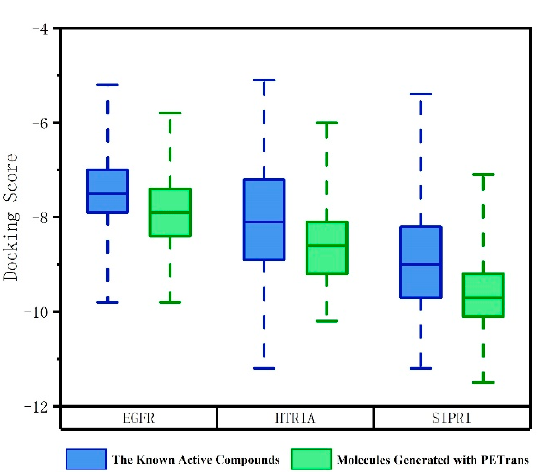
Figure A1. Distributions of the docking scores of the generated molecules for EGFR, HTR1A and